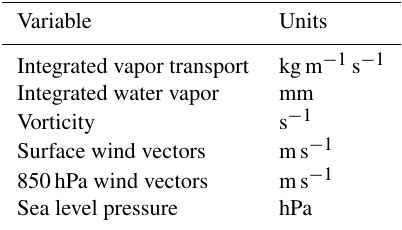
Table 1. Variables for the definition and characterization of TCs and